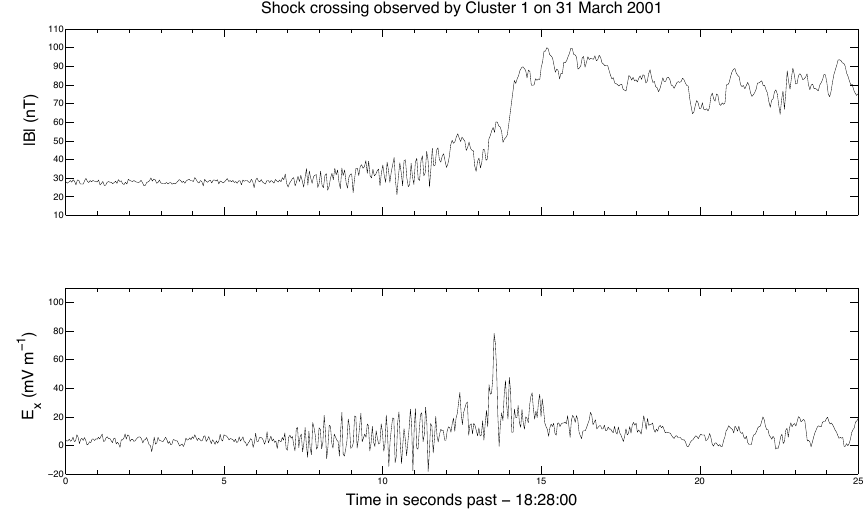
Fig. 2. A shock crossing observed by the Cluster 1 spacecraft at 18:28 on 31 March 2001. The upper panel shows the magnitude of the magnetic field profile measured the Cluster 1 FGM instrument across the shock. The lower panel shows the x-component of the electric field recorded by the EFW instrument over the same time interval (in the spacecraft spin